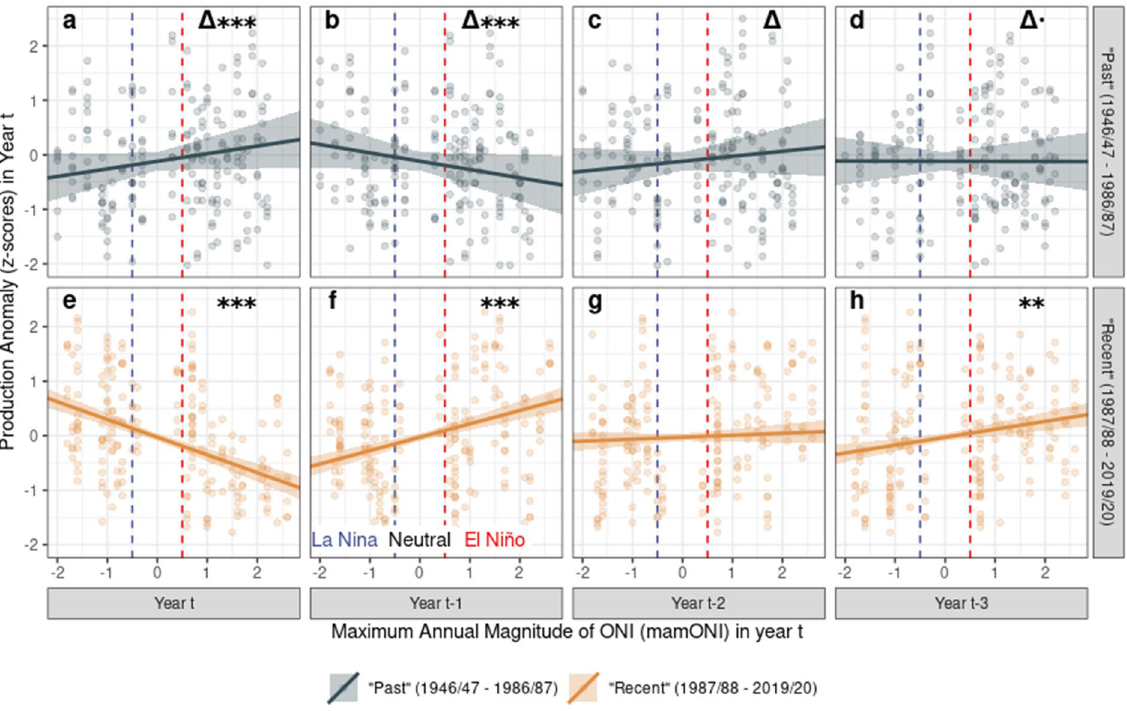
Figure 3. The changing response of cocoa production to mamONI over time in the Regional dataset, separated into “past” and “recent” purchase years. Vertical dashed lines delineate La Nina (mamONI ≤ − 0.5), Neutral (− 0.5 < mamONI < 0.5) and El Nino (mamONI ≥ 0.5) conditions. Lines show the best linear fits and standard errors derived from a single ANCOVA model fitting a two-level factor splitting the data into two time periods as an interaction with each of the four year delays. Significance stars denote the probability that: top row ( a – d )— the slopes for each year (columns) differ from one another; bottom row ( e – h )—the slope differs from zero